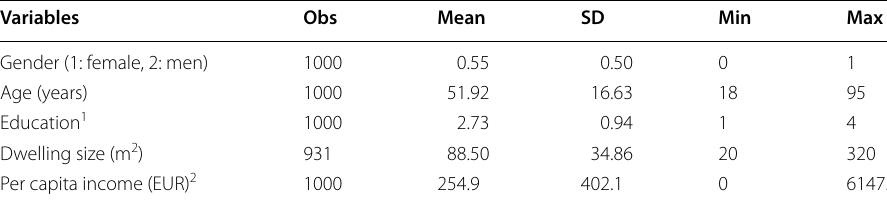
Table 1 Demographic variables: descriptive